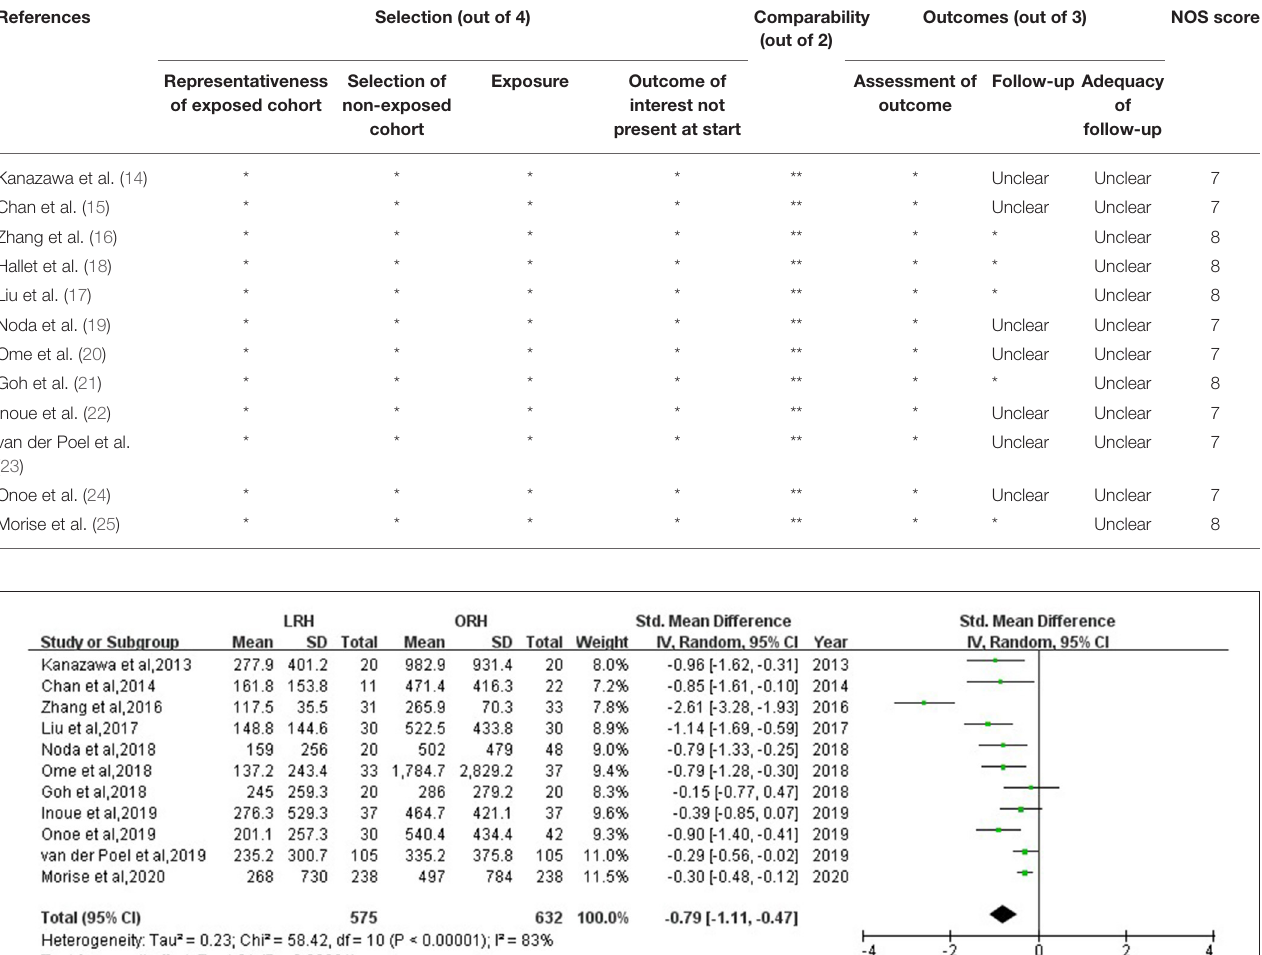
TABLE 4 | Quality assessment using Newcastle–Ottawa Scale (NOS).